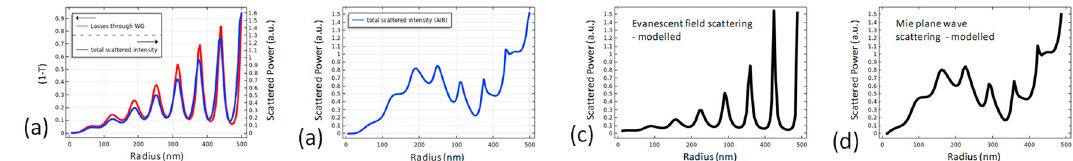
Figure 2. Simulated ( a , b ) and modelled ( c , d ) signals as a function of particle radius: ( a ) Total scattered intensity from TIR evanescent field scattering simulation compared to the losses of transmission through the waveguide. ( b ) Simulated MIE scattering of a plane wave. ( c ) Total scattered intensity from the analytical model of evanescent field scattering. ( d ) Modelled Mie scattering of a plane